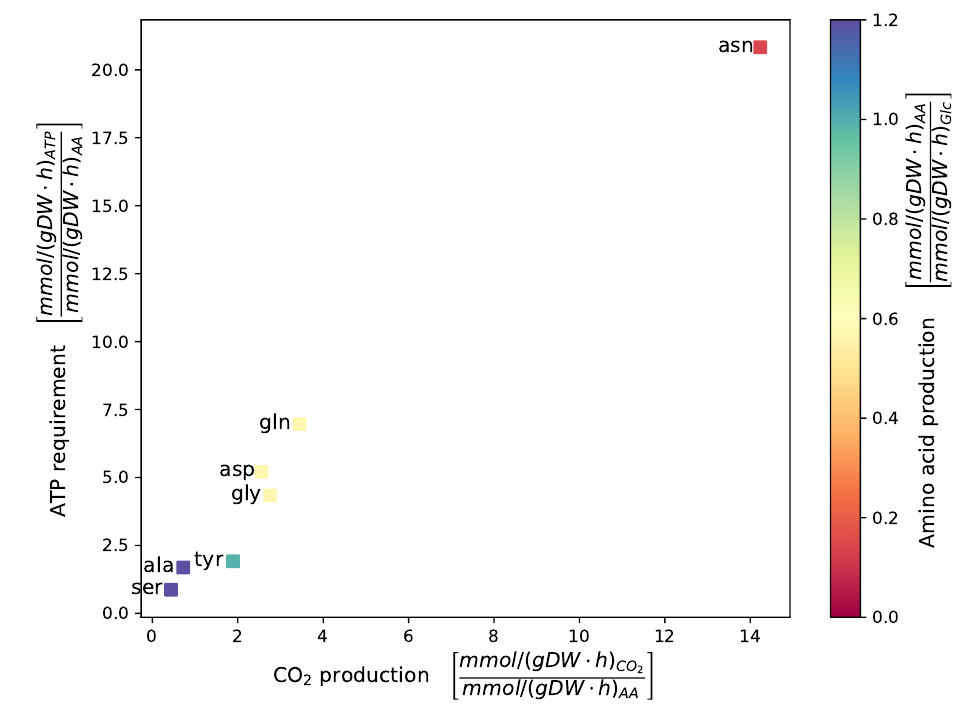
Figure 2. Amino acid production in D. pigrum . The exchange reaction of the amino acid of interest was closed to investigate the amino acid production capacity of D. pigrum in silico. A sink reaction of the respective amino acid was optimized while maintaining the growth rate at a fixed value of 0.2mmol/ ( gDW · h ) and maximum growth rate 0.278mmol/ ( gDW · h ) . Only the seven shown amino acids could be synthesized de novo. For every amino acid, the ATP requirement and the CO 2 production were calculated. The color indicates the amino acid production rate concerning the carbon source (glucose). Amino acids are shown with their respective three-letter